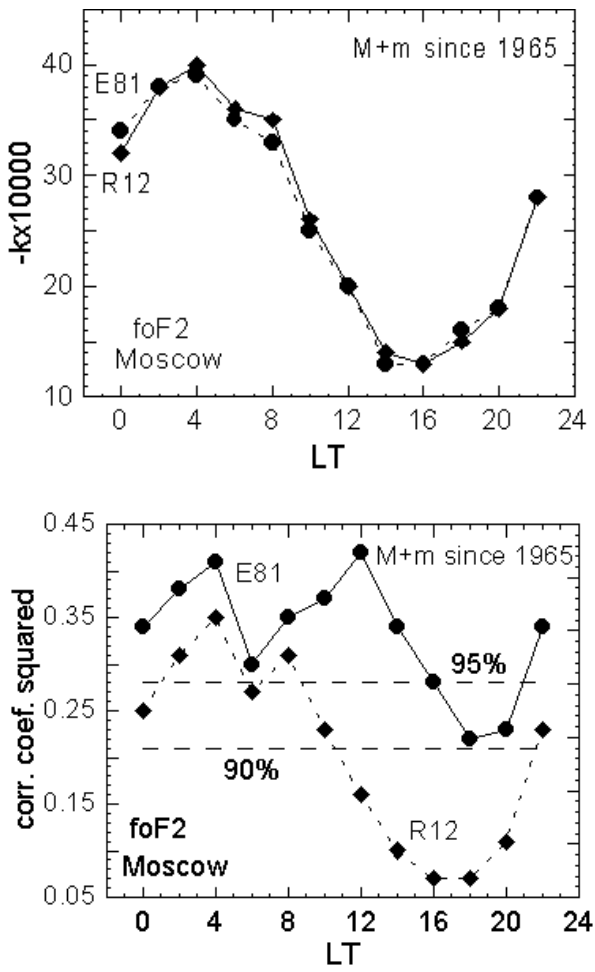
Fig. 2. Relative trends of fo F2 for the Moscow station (top) and the correlation coefficient squared (bottom panel) for the data of the top panel. Only the years around maxima and minima of solar activity since 1965 were used (see Danilov and Mikhailov,